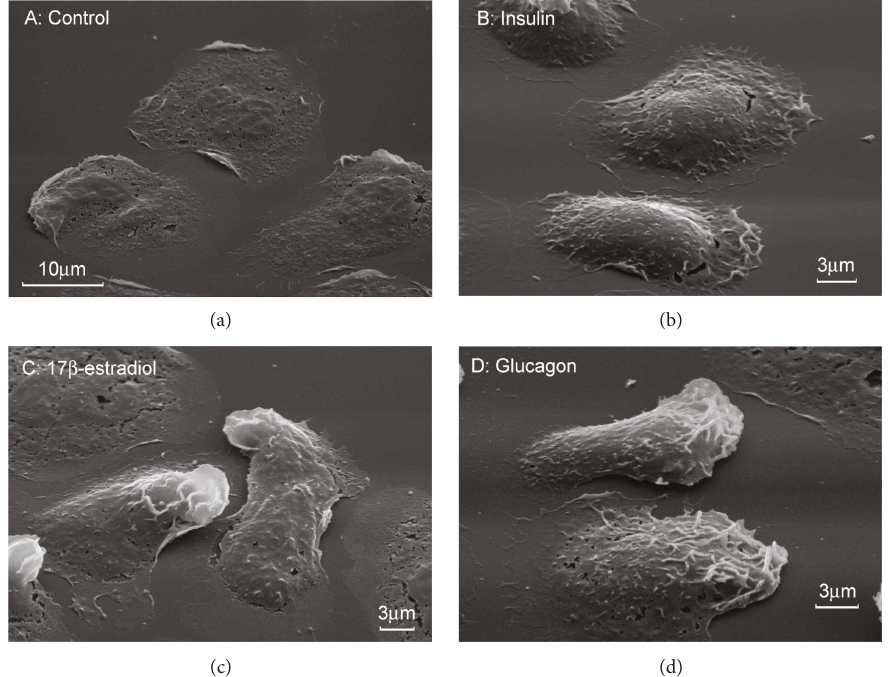
Figure 1: E ff ect of hormones on the morphology of human neutrophils attached to fi bronectin. Scanning electron microscopy images of neutrophils that were attached to fi bronectin for 20 min in control conditions (a) or in the presence of 0.1 μ M insulin (b), 0.1 μ M E2 (c), or 0.1 μ M glucagon (d). Pictures represent typical images observed in two independent